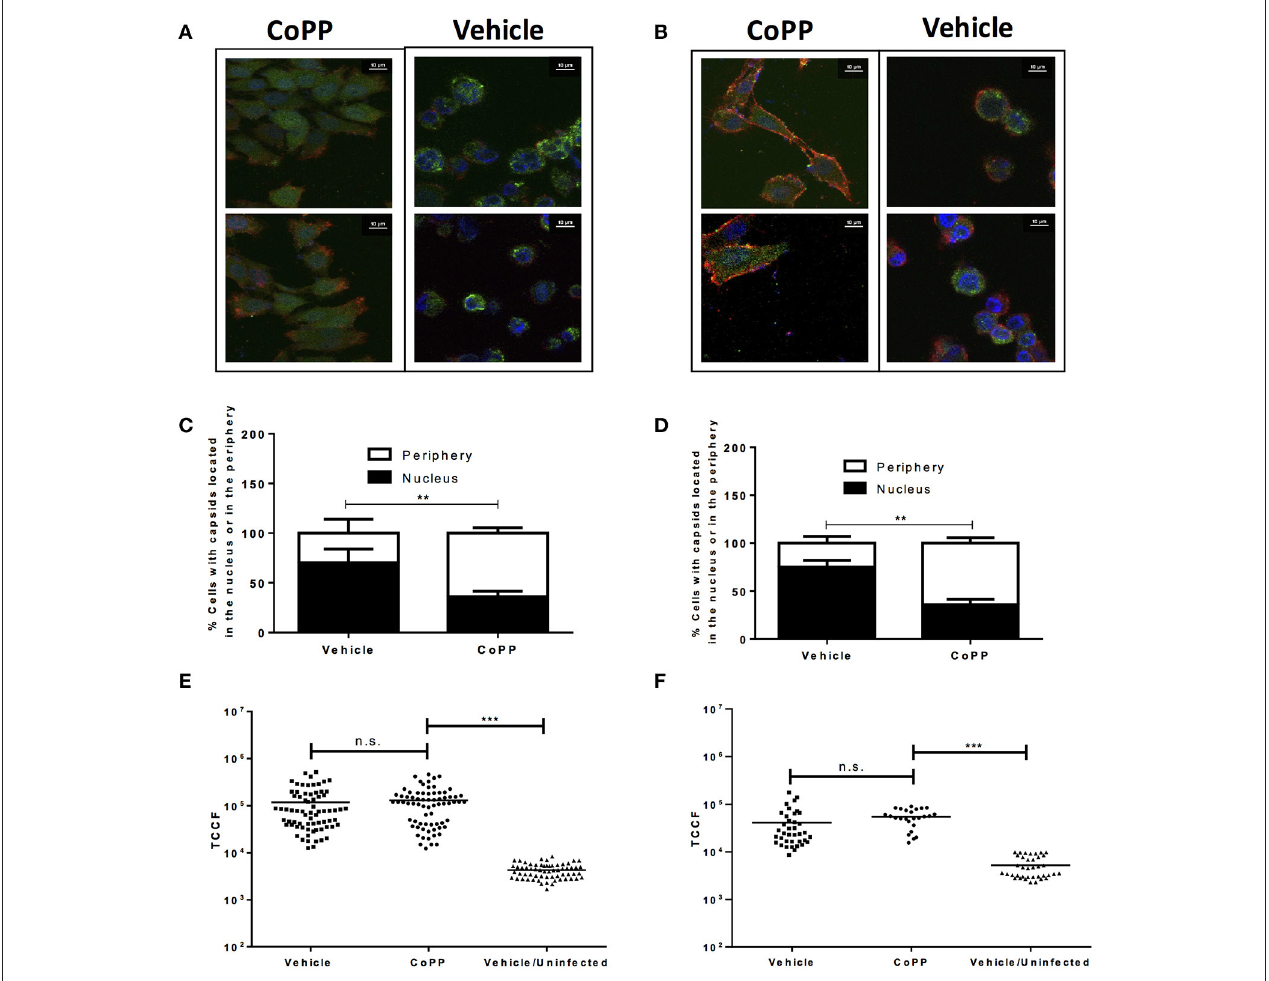
FIGURE 4 | Pharmacological induction of HO-1 with CoPP modulates capsid distribution in infected cells and elicits differential cell morphology after treatment after HSV-infection. Representative confocal microscopy images of (A) . Vero and (B) . HeLa cells treated or not with CoPP and infected with an HSV virus encoding a structural GFP fluorescent capsid (green: GFP-capsid fusion protein). Cell nuclei were stained with Hoescht (blue), and membrane were stained with WGA (red) (C,D) . Quantification of the distribution of capsid GFP-fluorescence in treated and infected Vero (left) and HeLa cells (right), respectively relative to the position of the nucleus. An average of fifteen fields and 150–200 cells were analyzed per experiment in a blind manner (E,F) . Quantification of total green fluorescence (virus encoded structural GFP fluorescent capsid) in confocal microscopy images of HSV-infected Vero (left) and HeLa cells (right), respectively treated or not with CoPP. TCCF is the integral density of fluorescence of the region of interest minus the equivalent of the cell area*mean fluorescence intensity of the background in the complete z-axis of the analyzed cells. Representative confocal microscopy images at 63X magnification are shown. Data are means ± SEM of two independent experiments. One way ANOVA, Two-way ANOVA, and Tukey’s multiple comparison test were used for statistical analyses (** p < 0.01, *** p <